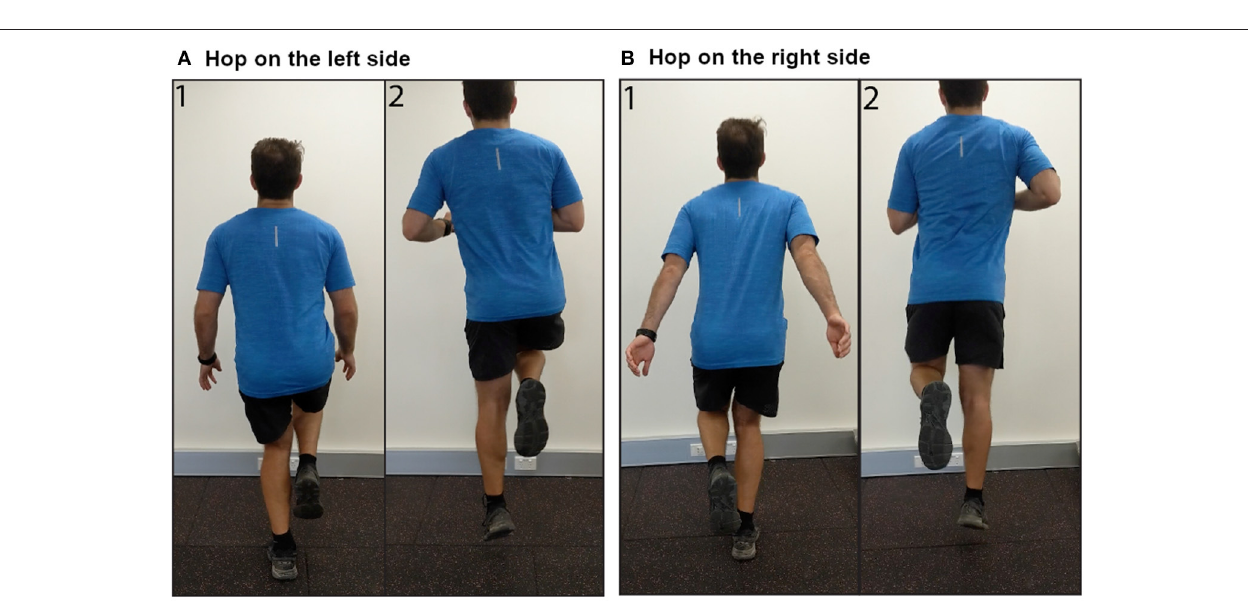
FIGURE 3 | Images demonstrating performance of single leg hops on the (A) left side, and (B) right